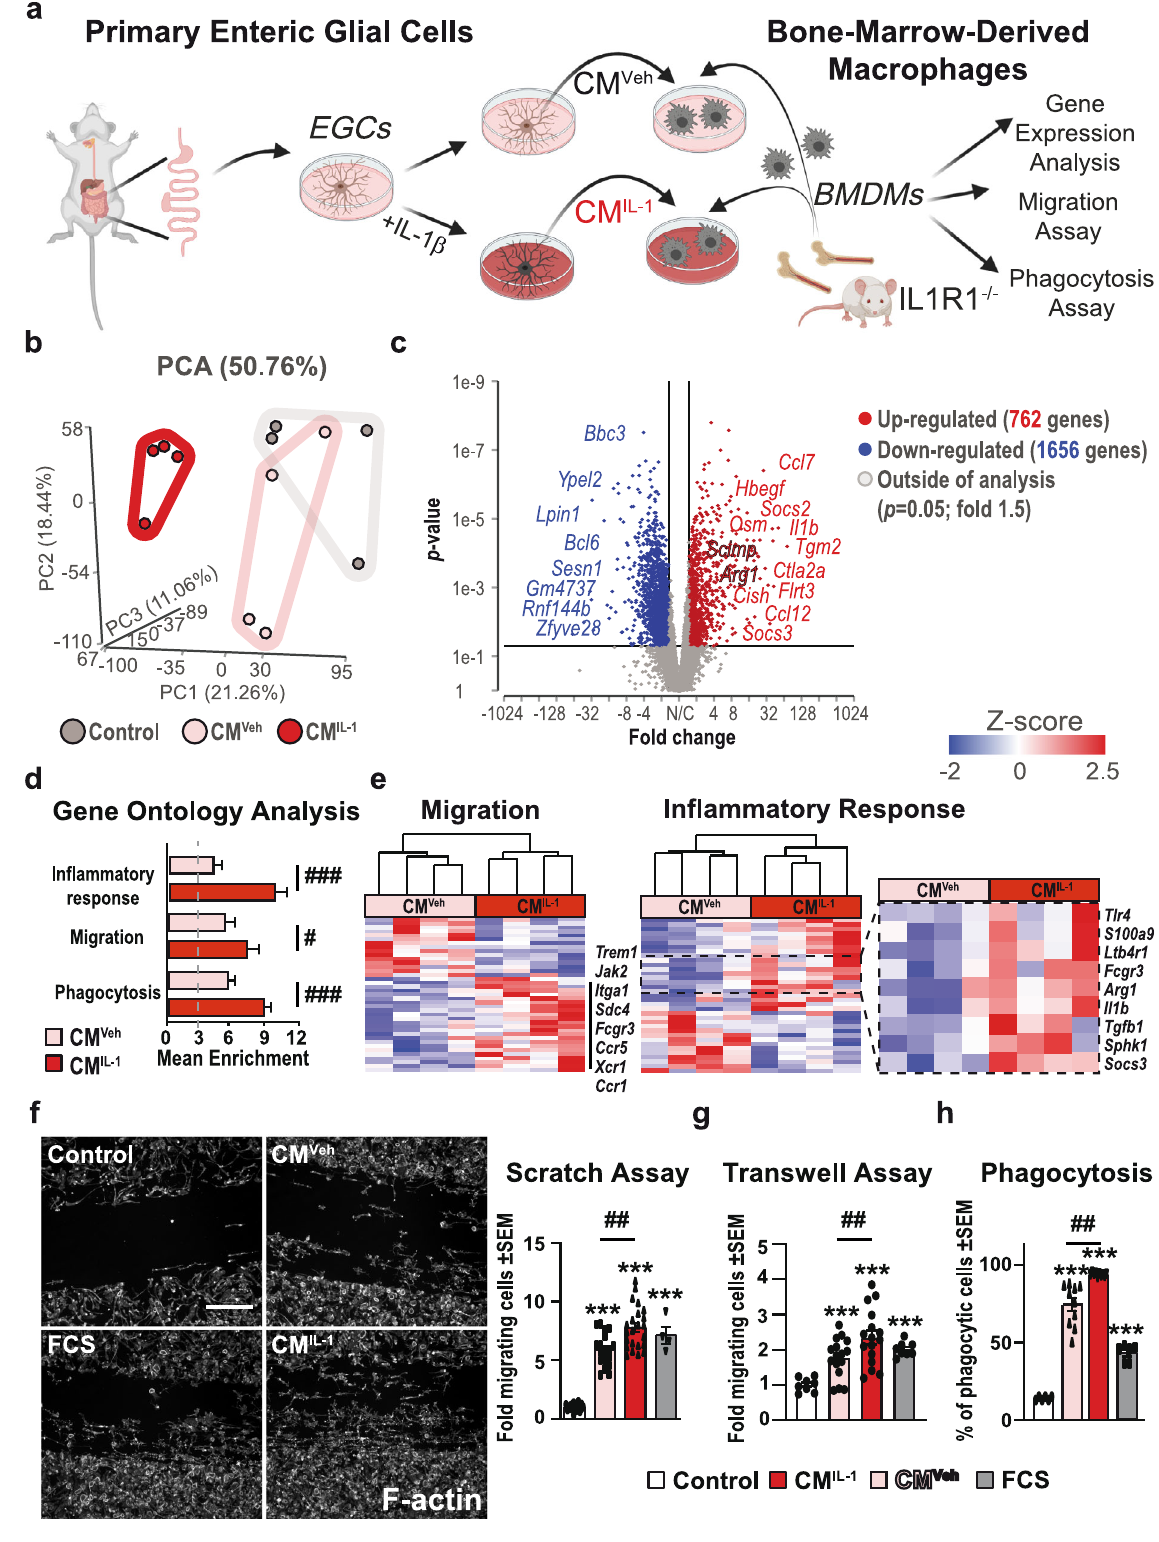
excessive in fl ammatory responses to restore intestinal